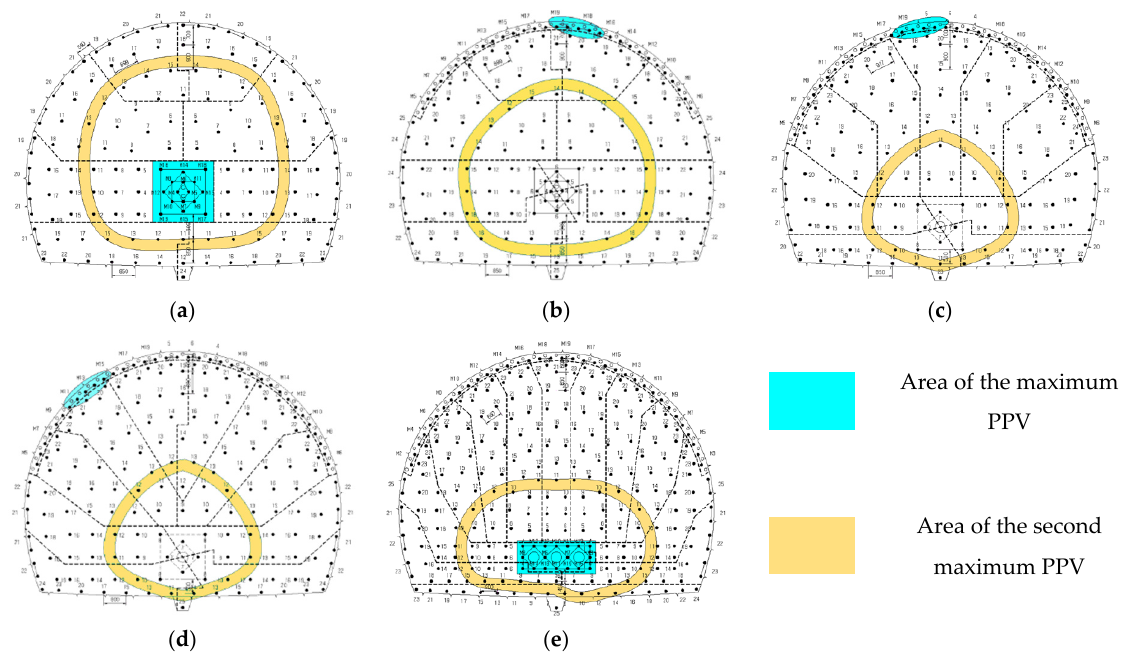
Figure 10. The area showing the first and second maximum peak particle velocity (PPV) values in ( a ) B, ( b ) CB-1, ( c ) CB-2, ( d ) CB-3, and ( e ) CB-4 test blast patterns.